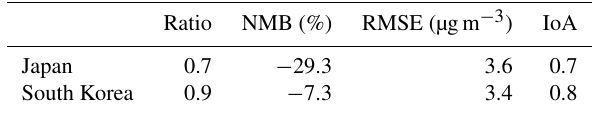
Table 3. Statistical results of model evaluation using satellite- retrieval PM 2 . 5 over Japan and South Korea. NMB refers to nor- malized mean bias, RMSE refers to root mean square error, and IoA refers to index of